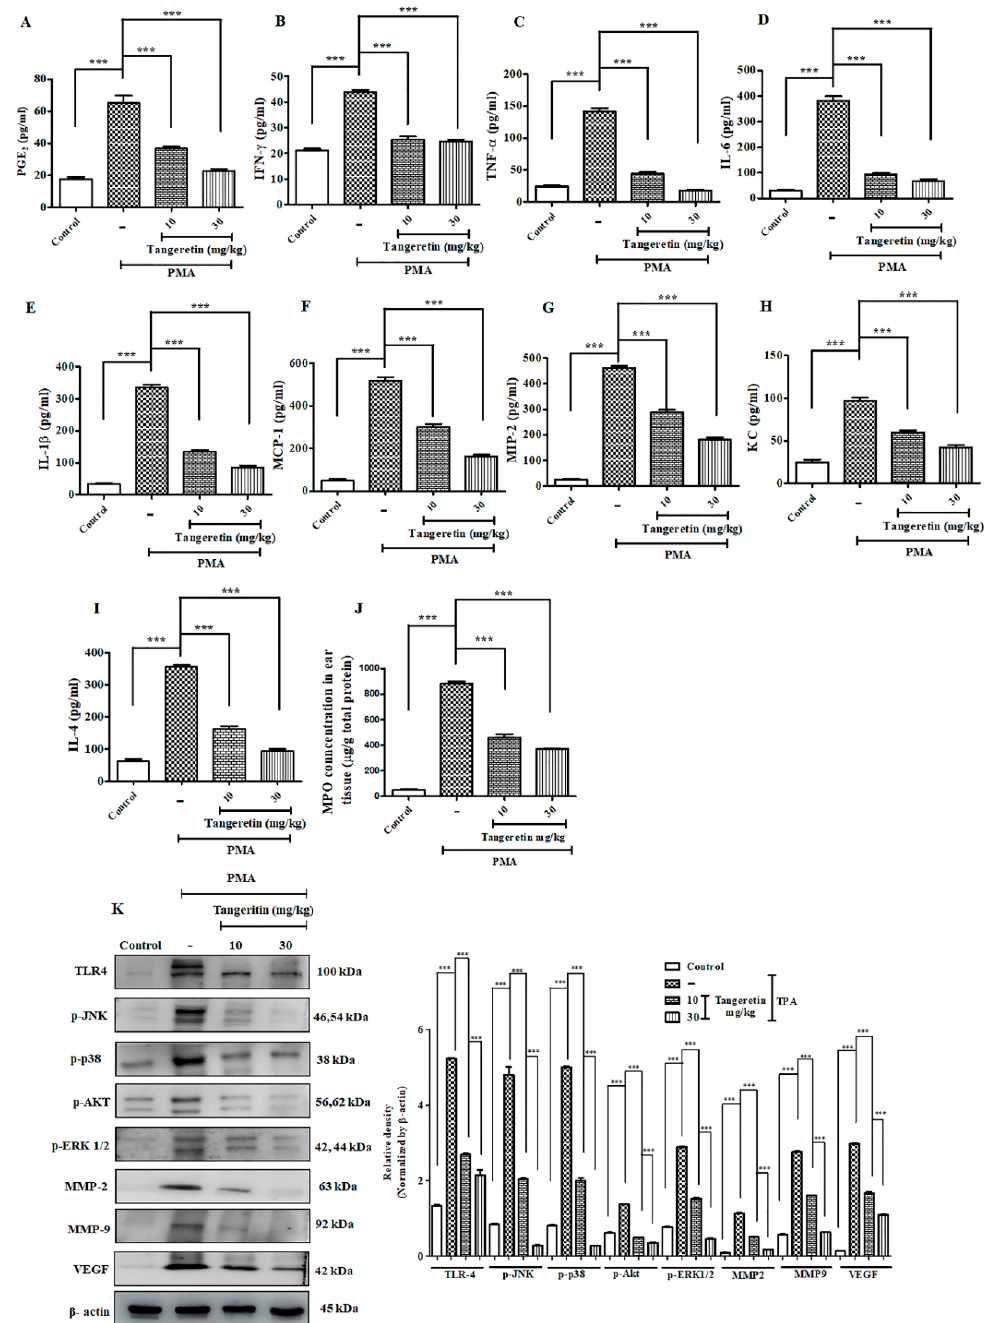
Figure 6. TAN exhibited potent anti-inflammatory response and blockaded cell proliferation pathway. Measurement of different inflammatory markers on mice after PMA treatment estimated by ELISA analysis. ( A ) PGE 2 , ( B ) IFN- γ , ( C ) TNF- α , ( D ) IL-6, ( E ) IL-1 β , ( F ) Cox-2, ( G ) MCP-1, ( H ) MIP-2, ( I ) Keratinocyte chemoattractant (KC), ( J ) IL-4, ( K ) myeloperoxidase assay (MPO), Western blotting analysis on ear tissue homogenates showed that TAN was able to significantly reduce the inflammatory response challenged by PMA (10 μ g/ear) and blockade the cell proliferation pathway validated. Densitometry analysis of these respective proteins were normalized by β -actin and evaluated through Image J software. The data are represented as mean ± S.D. of three independent experiments *** p < 0.001. PMA vs. control, TAN 10 mg/kg and 30 mg/kg vs. PMA. Statistical significance analysis was carried out through a one-way analysis of variance (ANOVA) prism.